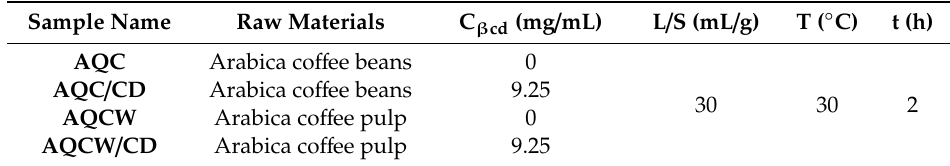
Table 3. Experimental conditions for the samples used in the sensory evaluation. t, time.